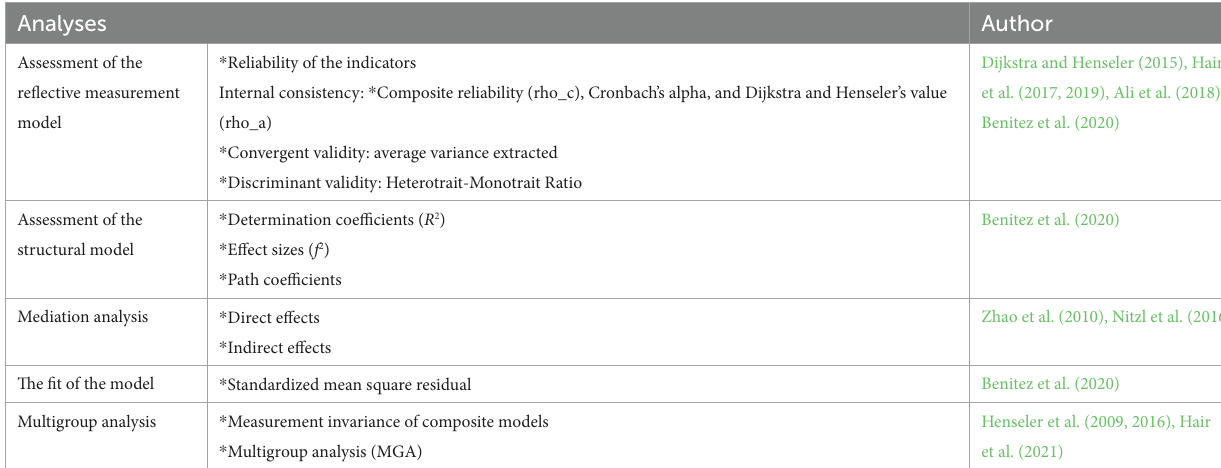
TABLE 3 The research analyzes through